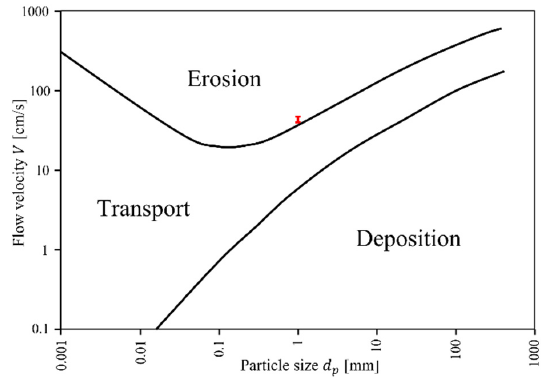
Figure 8. Particle motion in weak level. The upper side and lower side indicate x/D = 2.125 and x/D = 4, respectively. ( a ) 𝑢 (cid:2998) = 0.4 m/s; ( b ) 𝑢 (cid:2998) = 0.44 m/s; ( c ) 𝑢 (cid:2998) = 0.48 m/s; ( d ) 𝑢 (cid:2998) = 0.52 m/s.